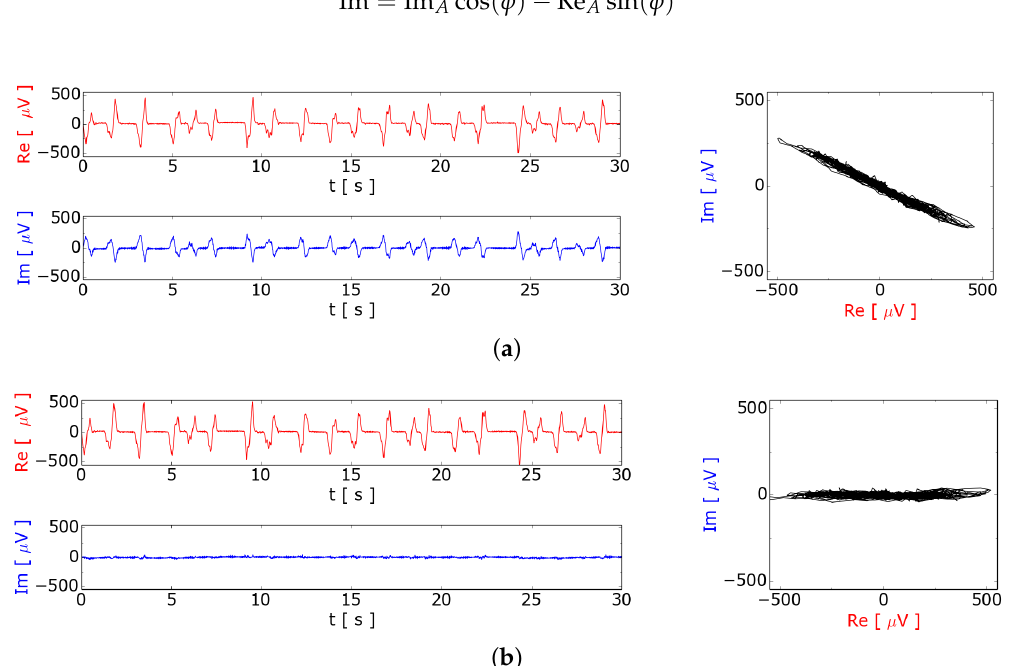
Figure 5. Processing of the quadrature demodulated signal from the planar gradiometer. The real part (I) is red and the imaginary part (Q) is blue in the plots. ( a ) Measured induced voltage Re A and Im A of the measurement system after quadrature demodulation and subtracting the average; ( b ) Signal rotated in the complex plane in order to minimize the imaginary part and maximize the real